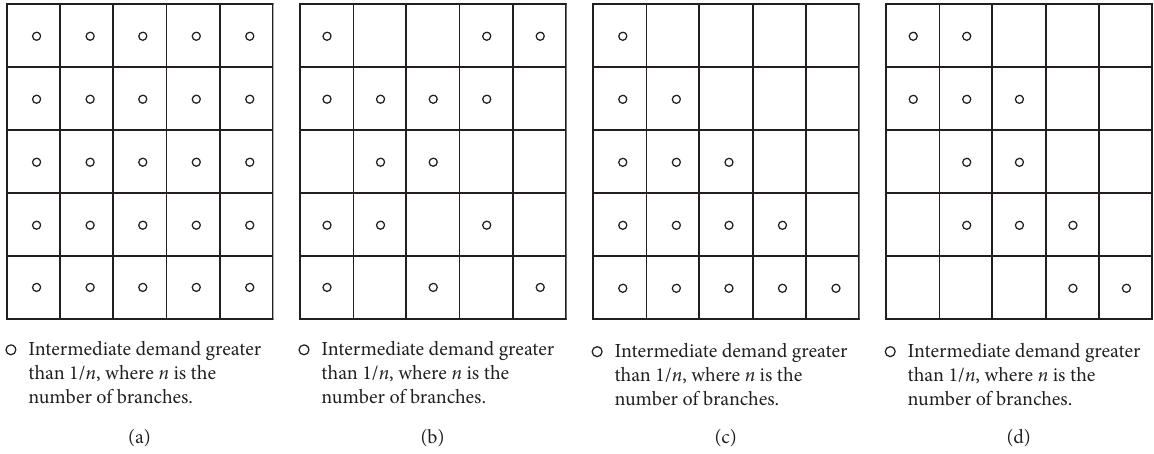
number of branches.